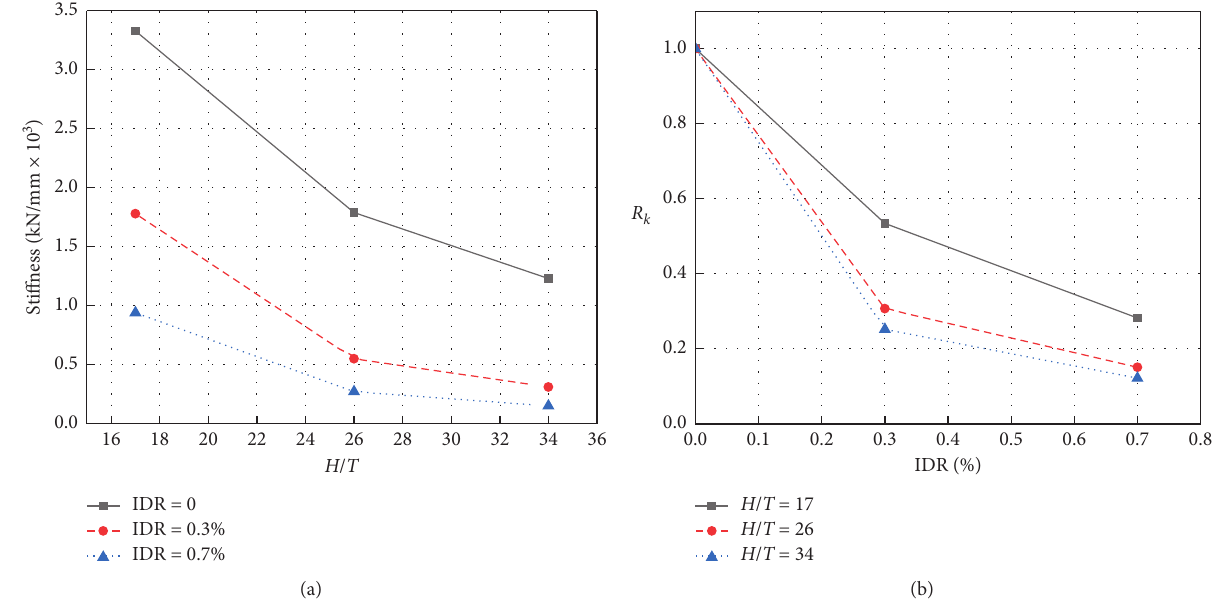
Figure 13: The effect (a) slenderness ratio and (b) IP damage on the OOP stiffness of the infill